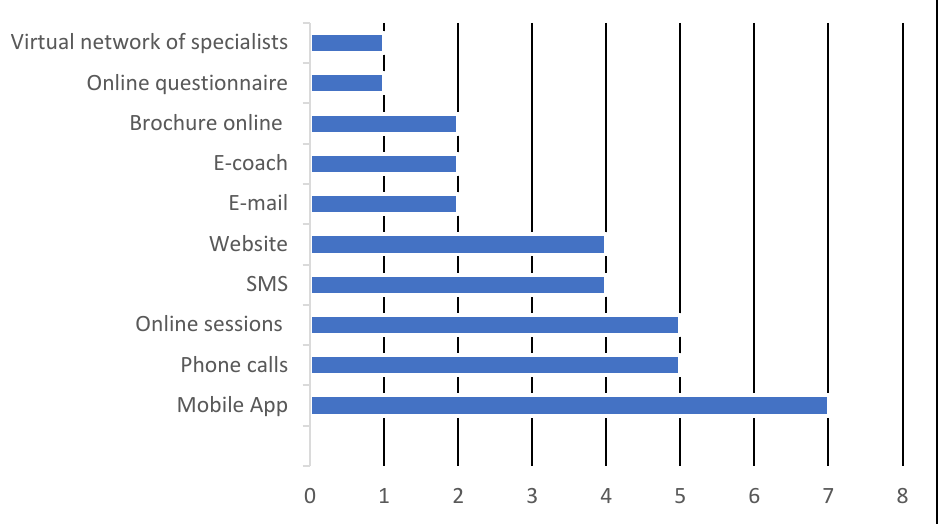
Figure 4. E-Health tools presented in the reviewed articles.